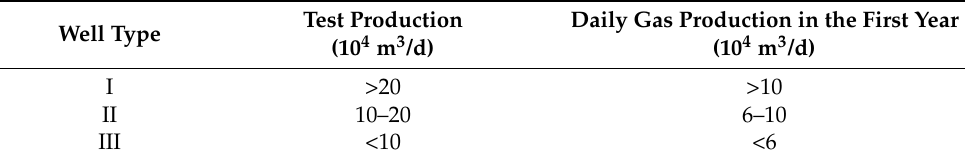
Table 3. Standards for classification of gas wells in Changning shale gasfield.